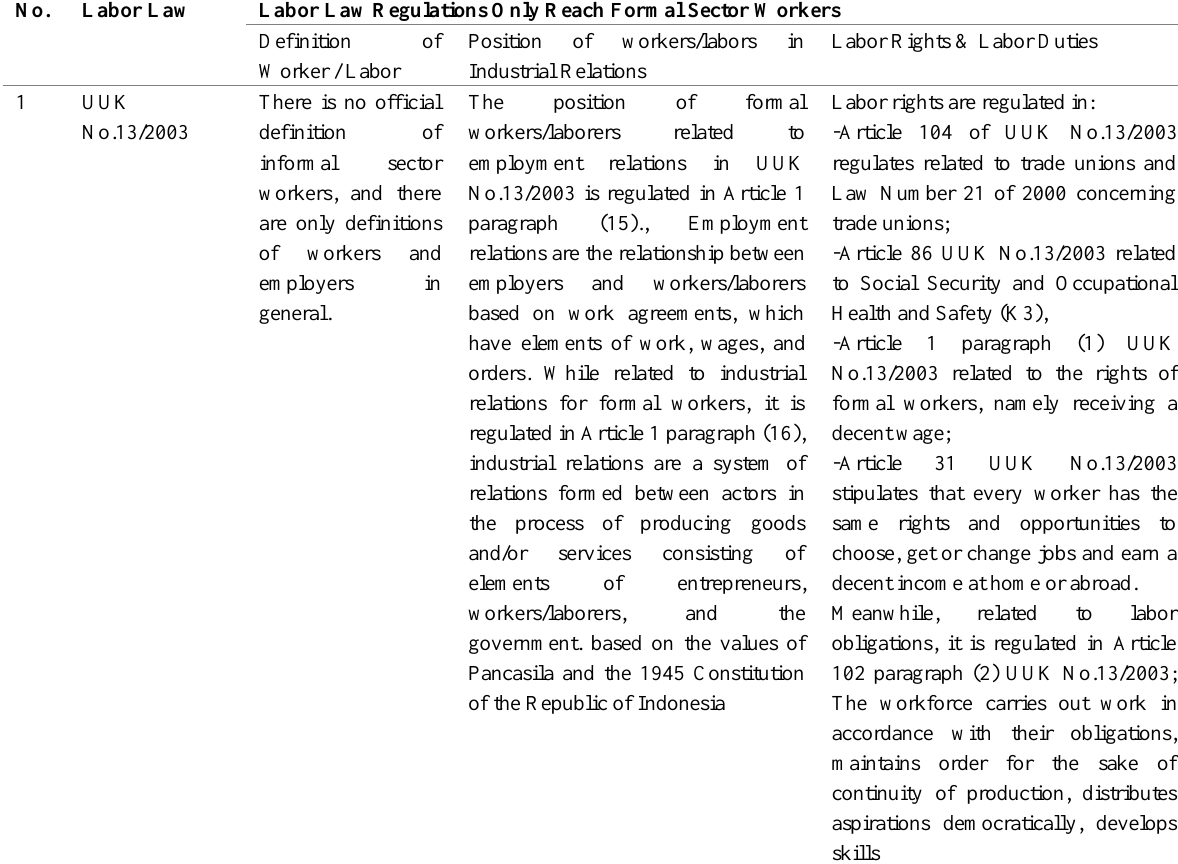
Table 3: Overview of Labor